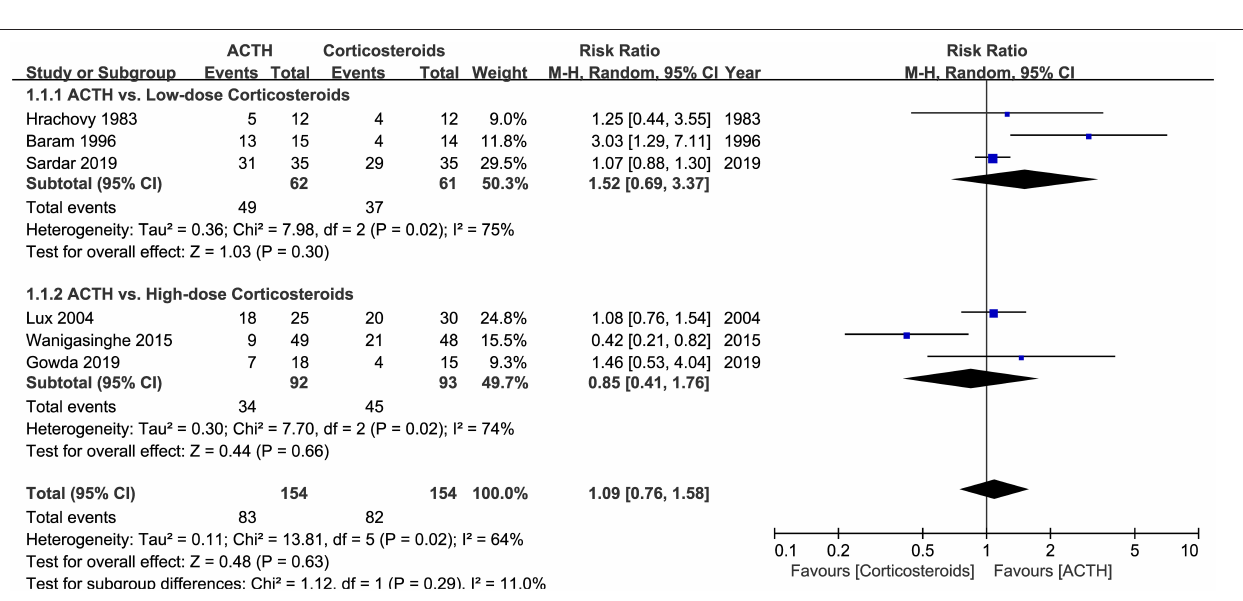
FIGURE 3 | Forest plot showing risk ratio (RR) and 95% CI of electro-clinical response between adrenocorticotrophic hormone (ACTH) and oral corticosteroids.